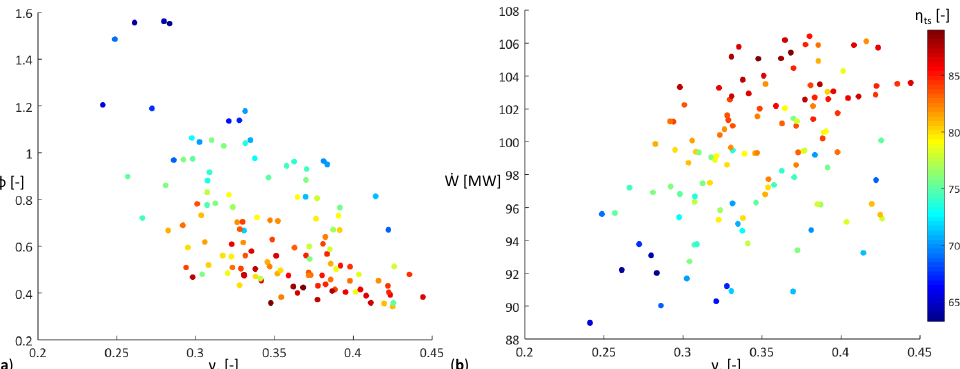
Figure 2. Preliminary design space: ( a ) Flow coefficient vs velocity ratio, ( b ) Power vs velocity ratio.